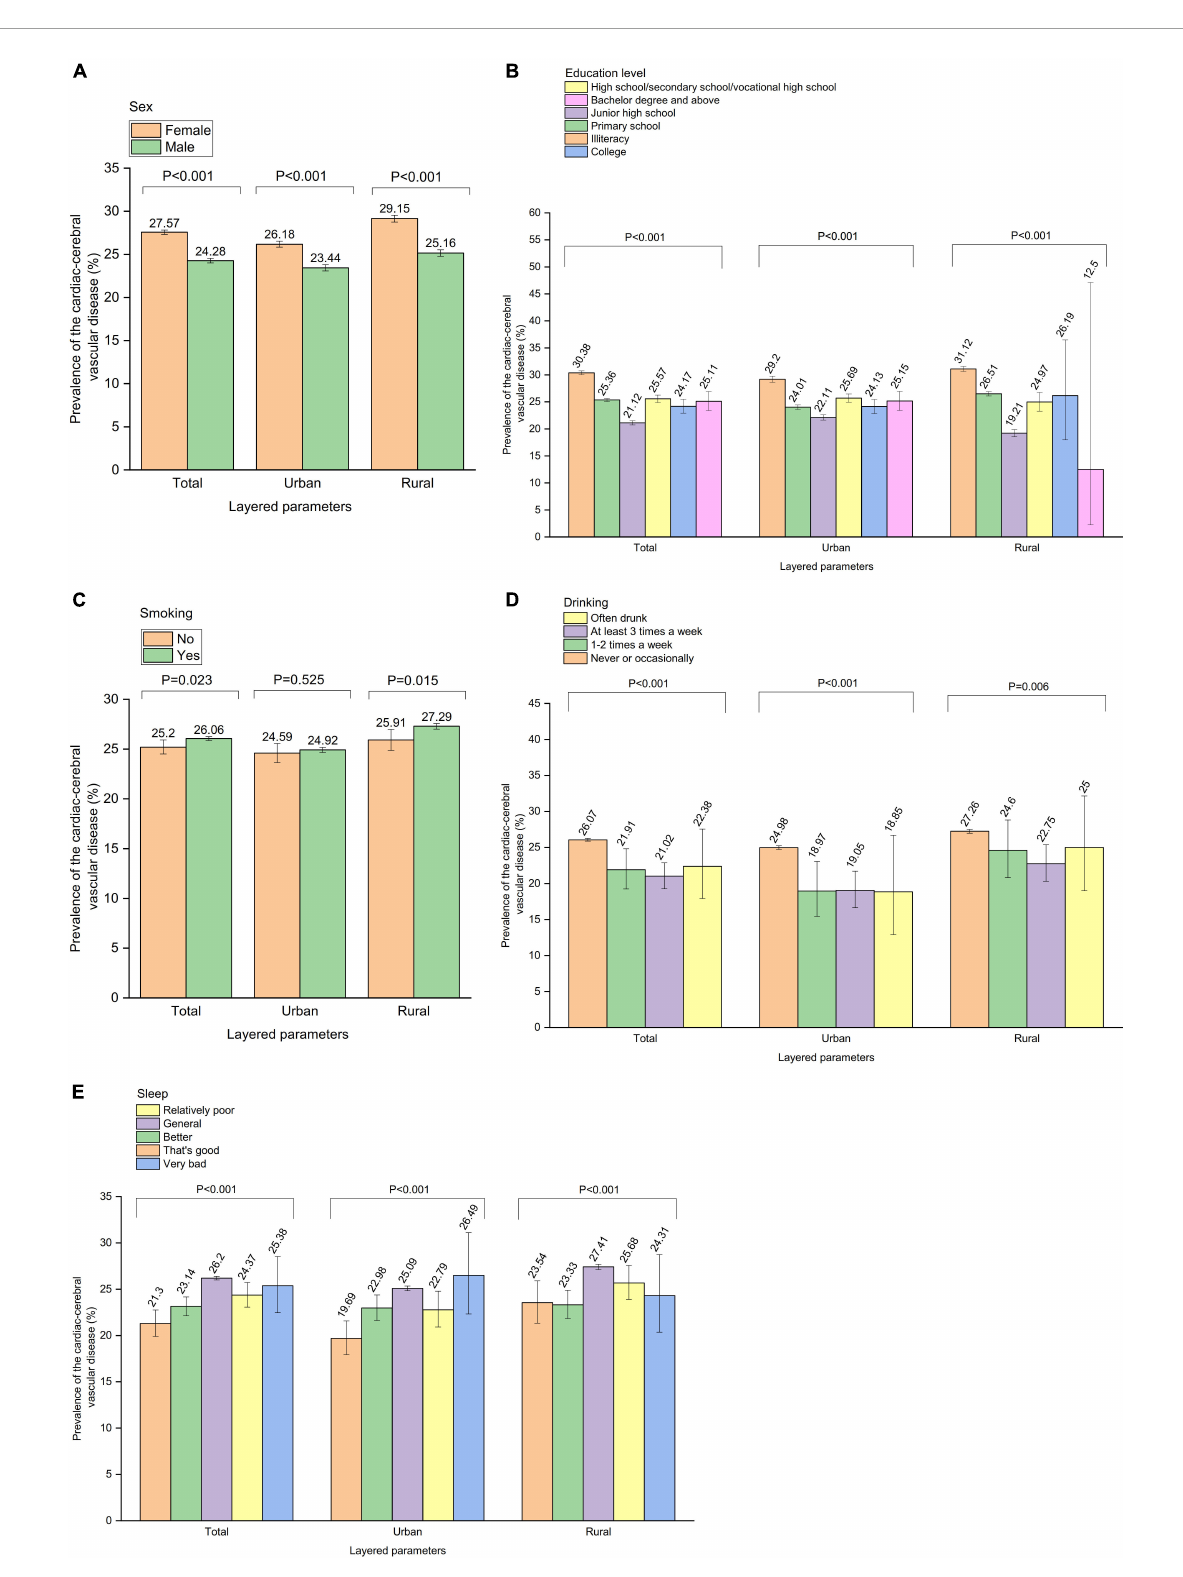
FIGURE4 The relationship between parameters and cardiac-cerebral vascular disease was further analyzed by “Urban and rural” stratification. Prevalence of the cardiac-cerebral vascular disease by (A) “Sex” stratification, (B) “Education level” stratification, (C) “Smoking” stratification, (D) “Drinking” stratification, (E) “Sleep”